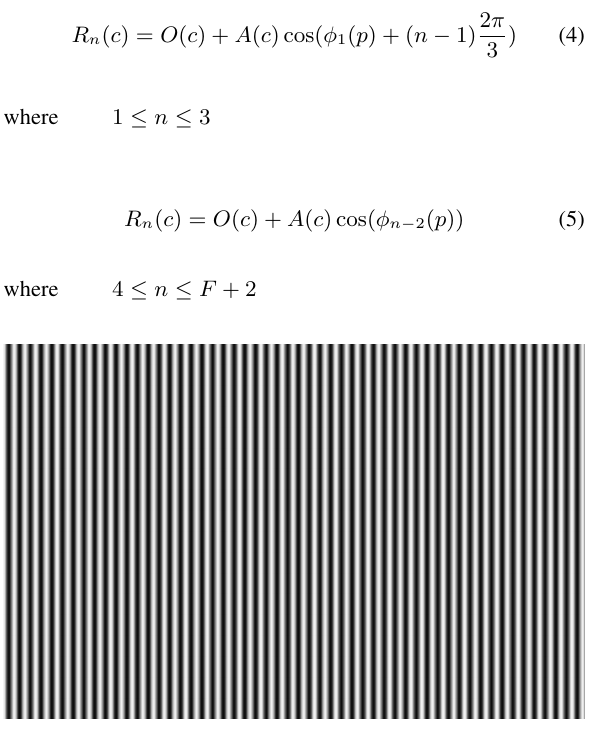
Figure 4: Micro phase shifting pattern